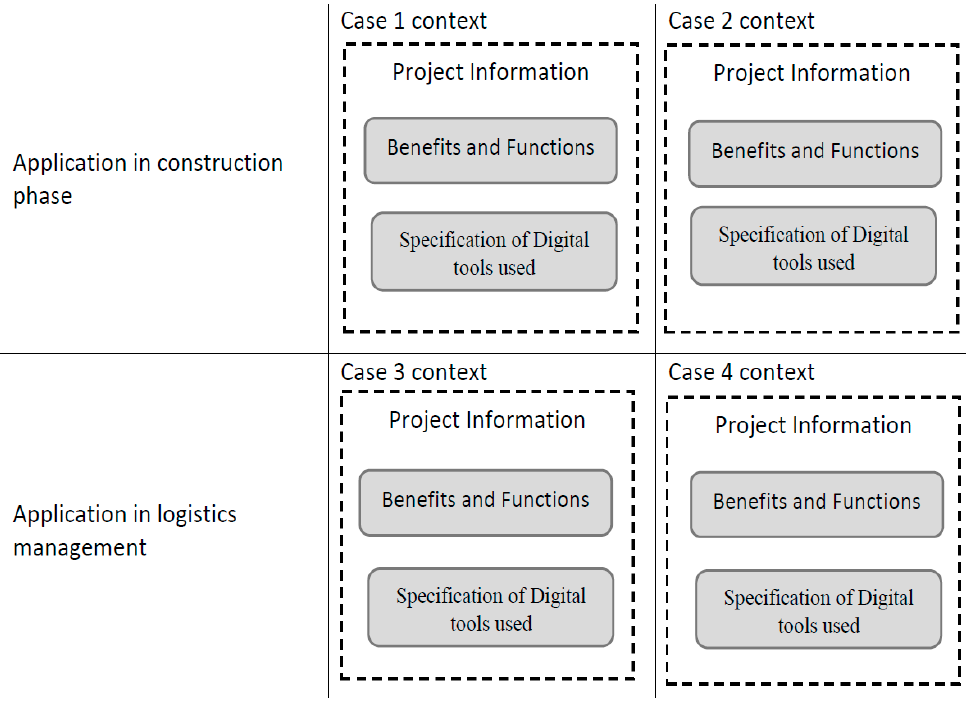
Figure 1. Case study framework developed based on Yin [29].